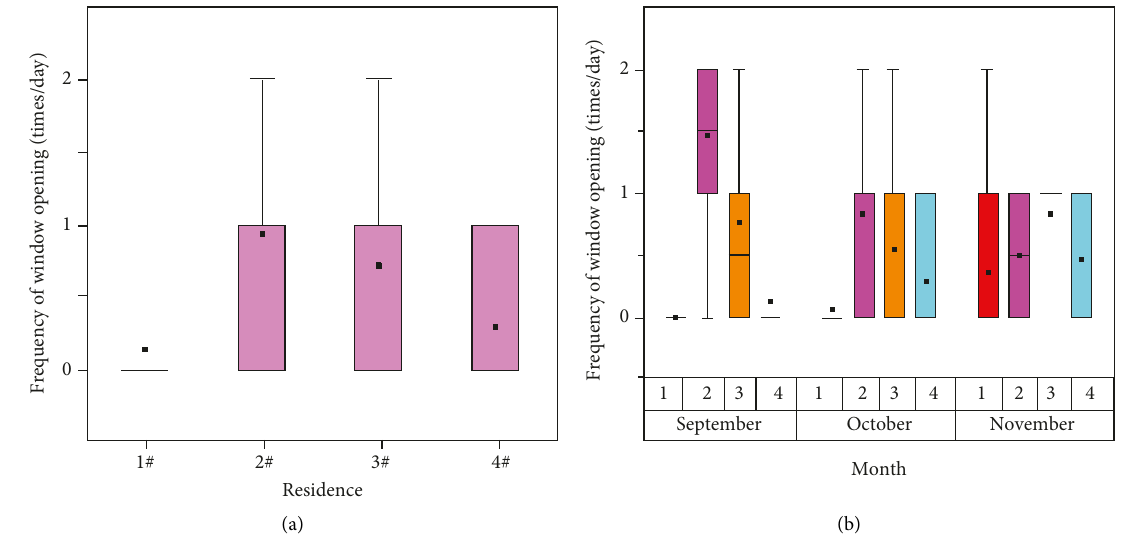
Figure 11: Box plot of window opening times for each residence: (a) total frequency of window opening and (b) frequency of window opening per month.